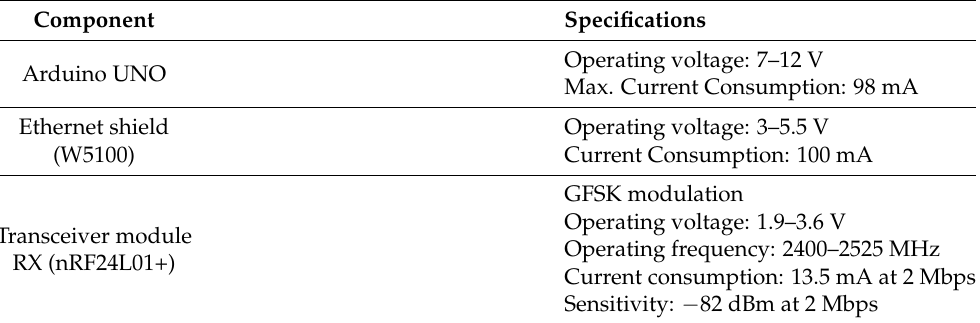
Table 4. RX node